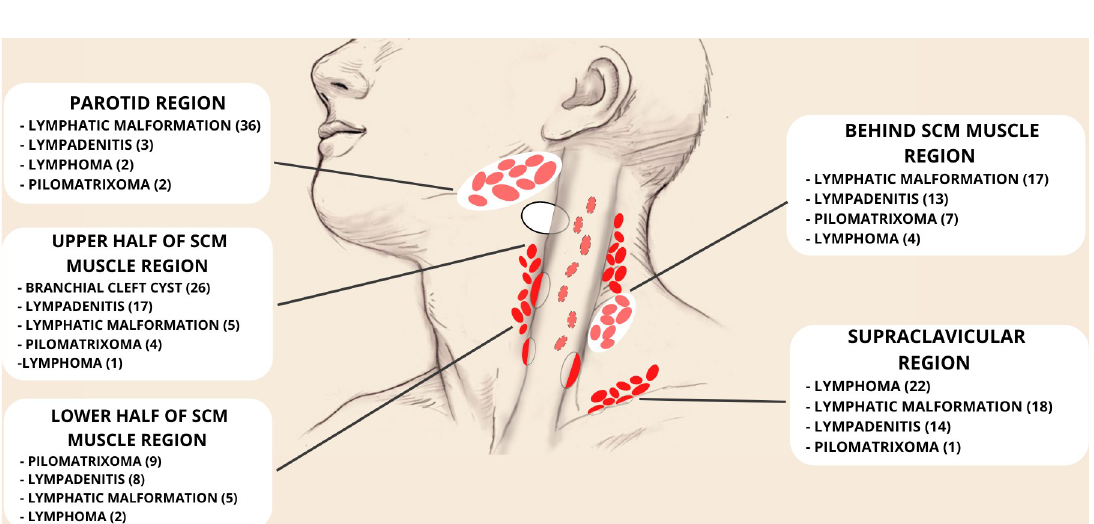
Fig 3. Anatomical scheme of lateral neck masses localization in our study (SCM—sternocleidomastoid).